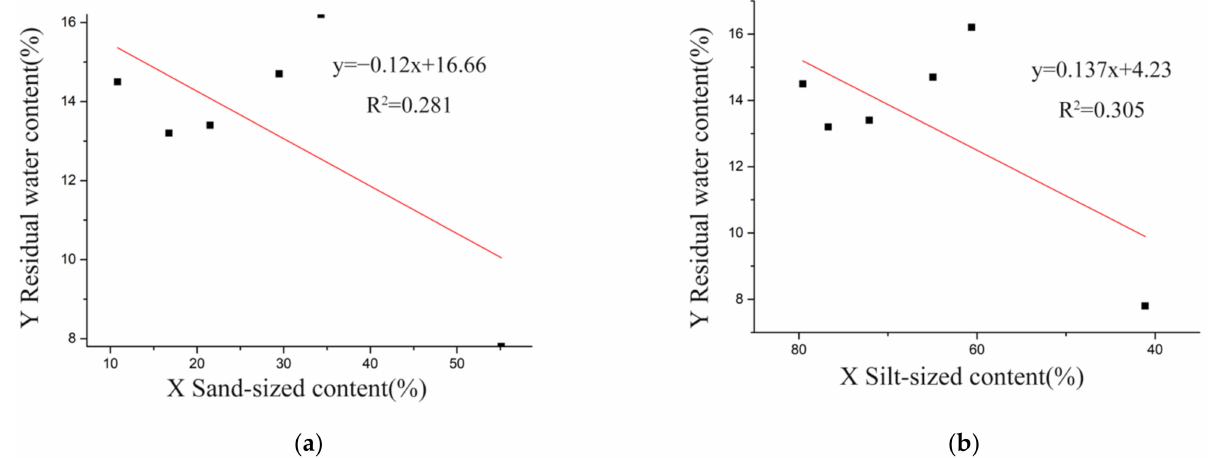
Figure 8. ( a ) Correlation between residual water content and sand-sized content; ( b ) correlation between residual water content and silt-sized